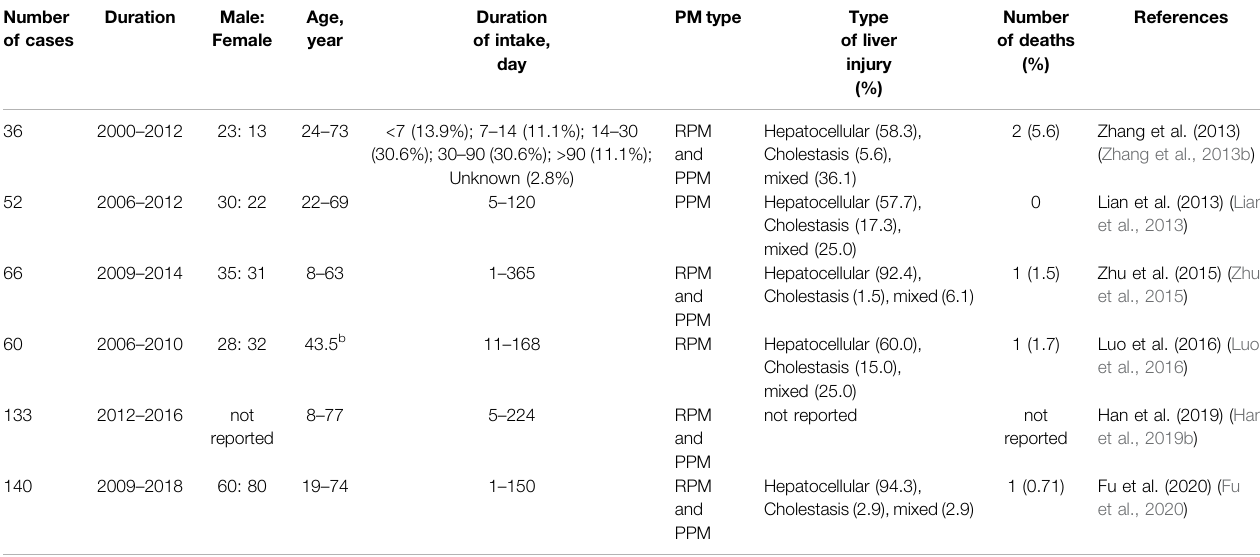
TABLE 1 | Representative studies a on liver injury caused by